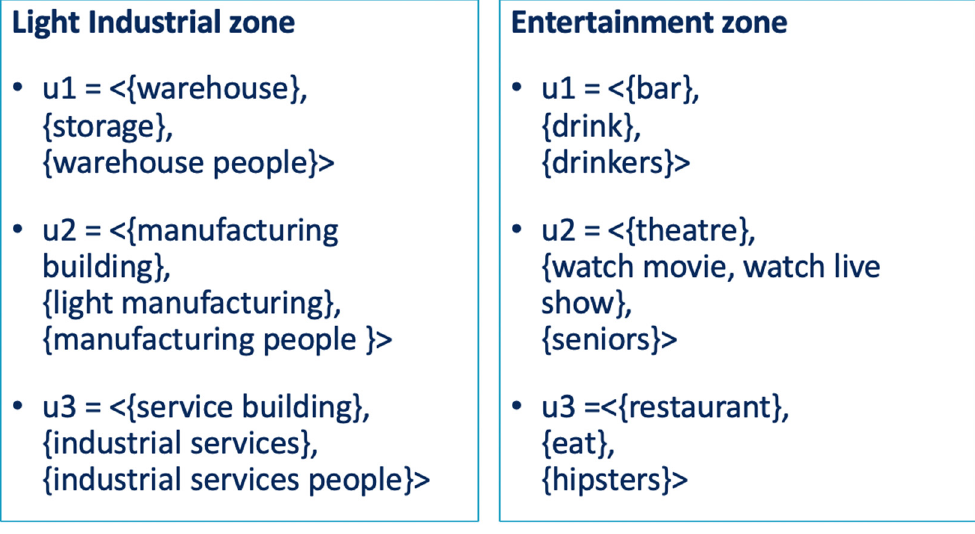
Figure 4. Example Genomes.